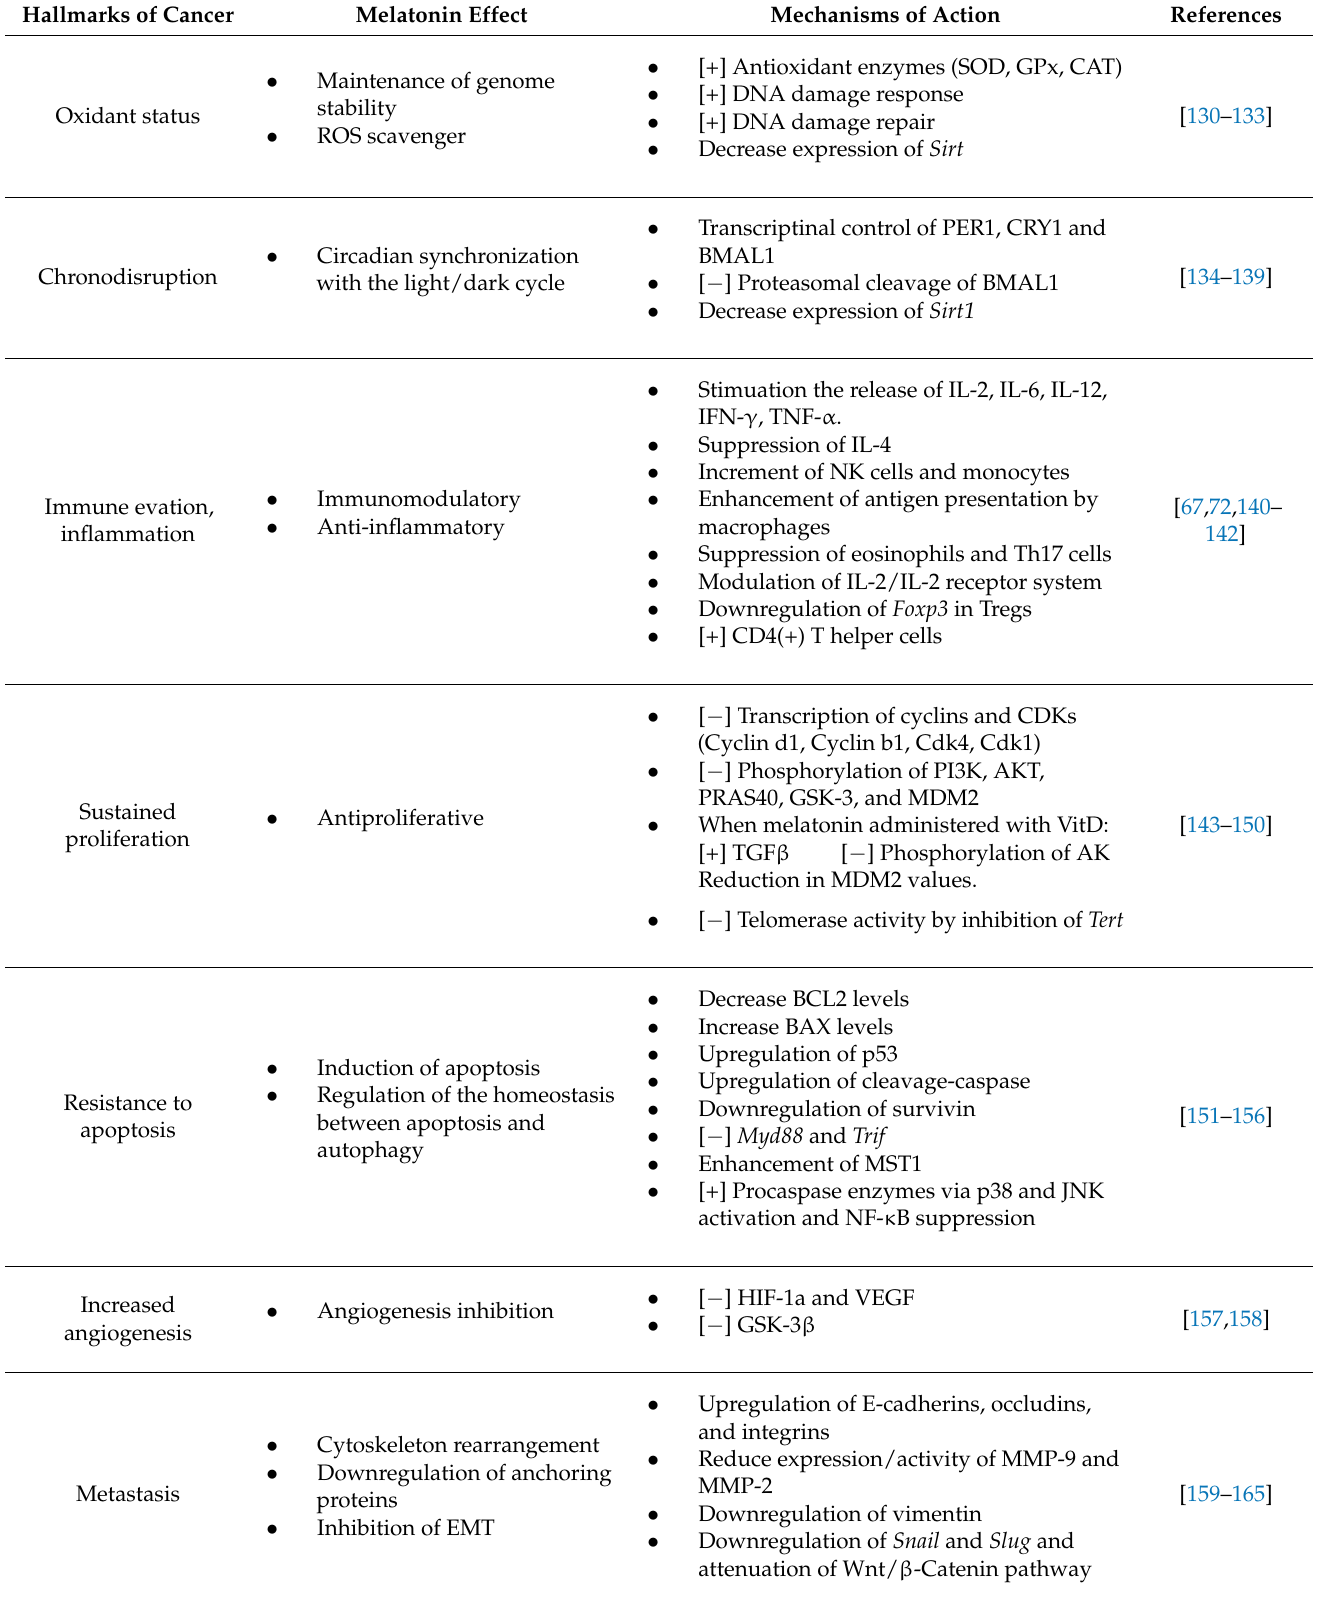
Table 1. Summary of the effects of melatonin and its mechanisms of action in some of the hallmarks of cancer. [+] stands for activation and [ − ] for